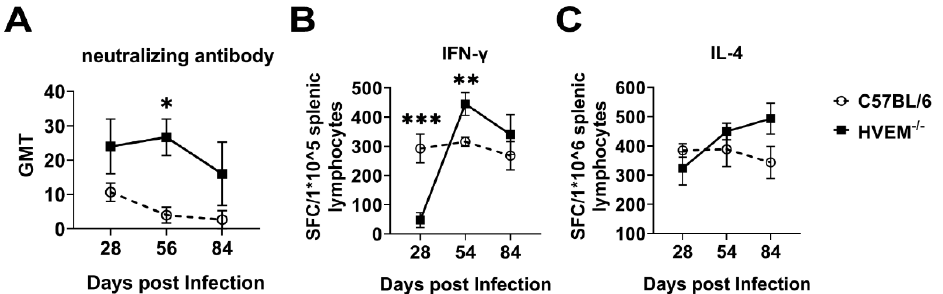
Figure 6. Dendritic cells infected with HSV-1 suppress innate immunity and weaken the adaptive immune response. ( A ) The levels of neutralizing antibodies in C57BL/6 and HVEM −/− mice were measured at different time points ( n = 3 per time point in each group). ( B ) ELISPOT analysis of gB 498-505 elicited IFN- γ -secreting T-cell responses within the splenic lymphocyte population from C57BL/6 and HVEM −/− mice. The samples were run in duplicate ( n = 3 per time point in each group). ( C ) ELISPOT analysis of gB 498-505 elicited IL-4-secreting T-cell responses within the splenic lymphocyte population from C57BL/6 and HVEM −/− mice. The samples were run in duplicate ( n = 3 per time point in each group). SFC, spot-forming cell. Statistical significance was assessed by two-way ANOVA with Holm – Sidak adjustment for multiple comparisons (*, p < 0.05; **, p < 0.01; ***, p < 0.001).